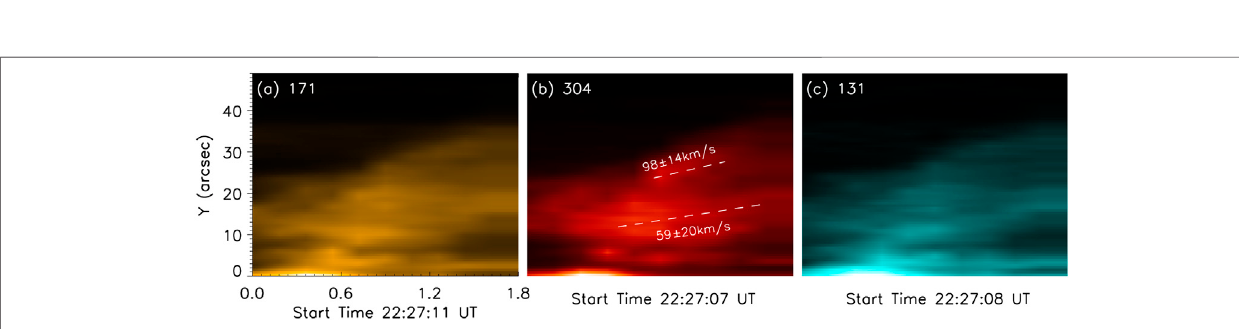
intensity along the jet spine at different moments, 22:31:11, 22:32: 11, 22:32:23, 22:32:59, separately. Here, the minimum intensity between the three peaks in Figures 7B,C is considered as the background intensity of the jet, the solid lines in Figures 7A – D show this intensity. When the intensity is 1.5 times of the background intensity, the dashed lines are plotted. In Figure 7B , there are three peaks above the dashed lines with